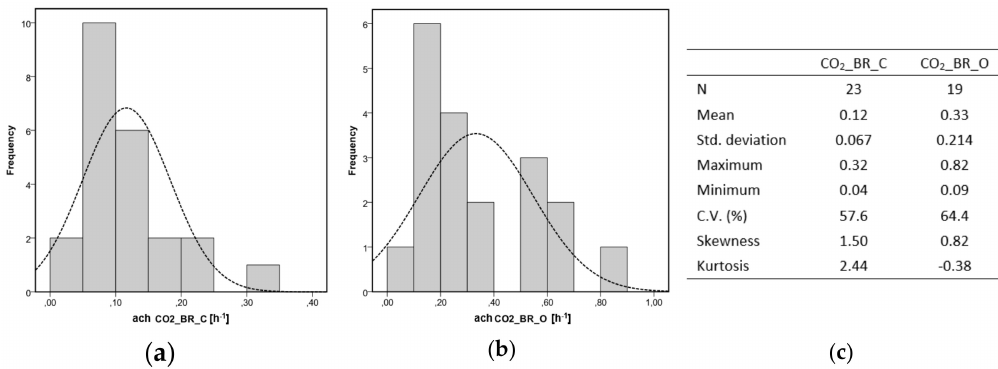
Figure 7. Carbon dioxide (CO 2 ) measurements of the air change rate in the bedroom (BR): ( a ) Histogram—door closed (CO 2 _BR_C); ( b ) Histogram—door open (CO 2 _BR_O); ( c ) Descriptive statistics